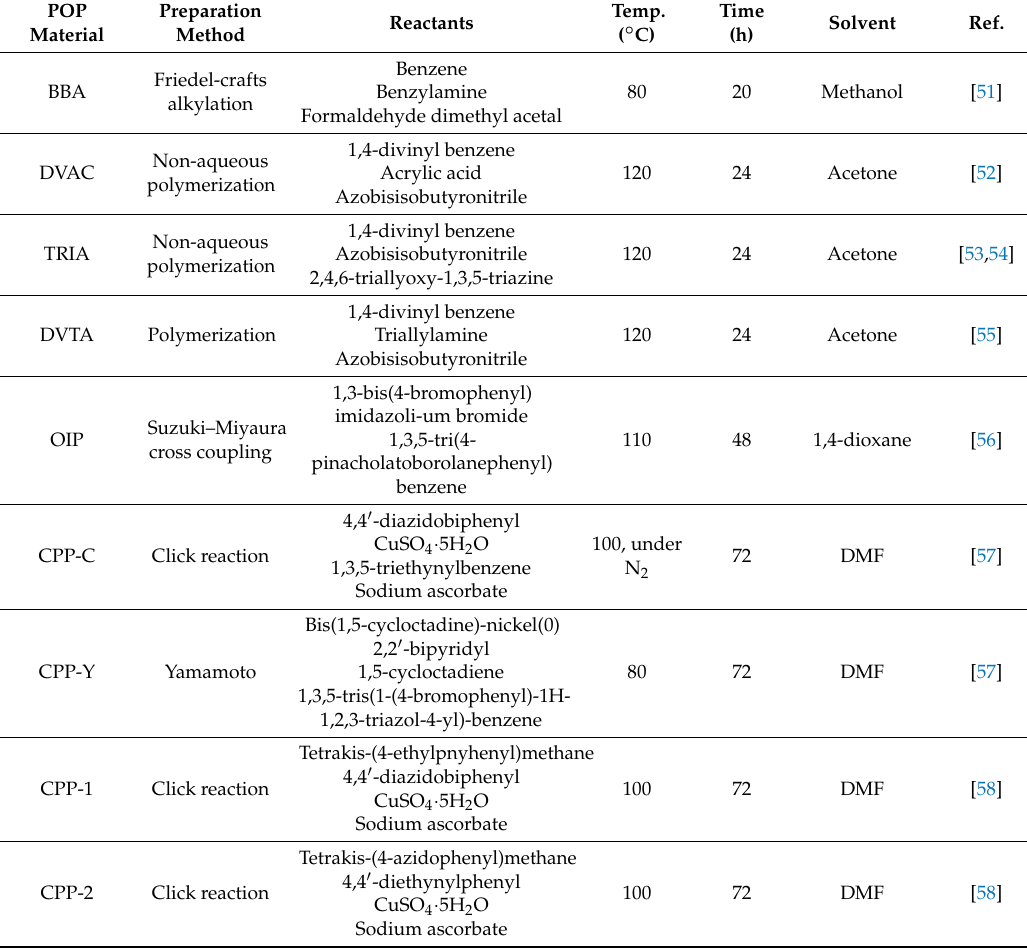
Table 1. Synthesis of porous organic